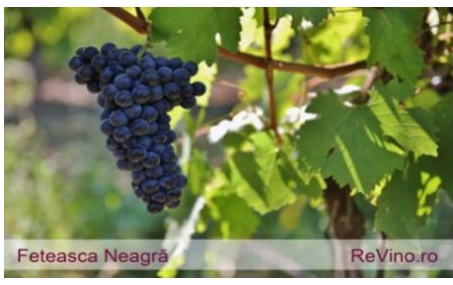
Figure 3. Feteasca Neagr ă grapes. Figure 4. Rar ă Neagr ă